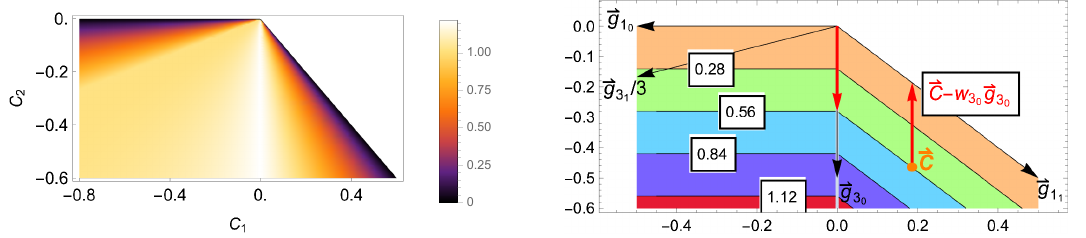
Figure 10. Left: the degeneracy δ in the positivity cone, defined in eq. (5.24). Right: the maximal possible value of w for ~C = (0 . 186 , − 0 . 464) , to illustrate eq. (5.10); see the discussion 3 0 in the main